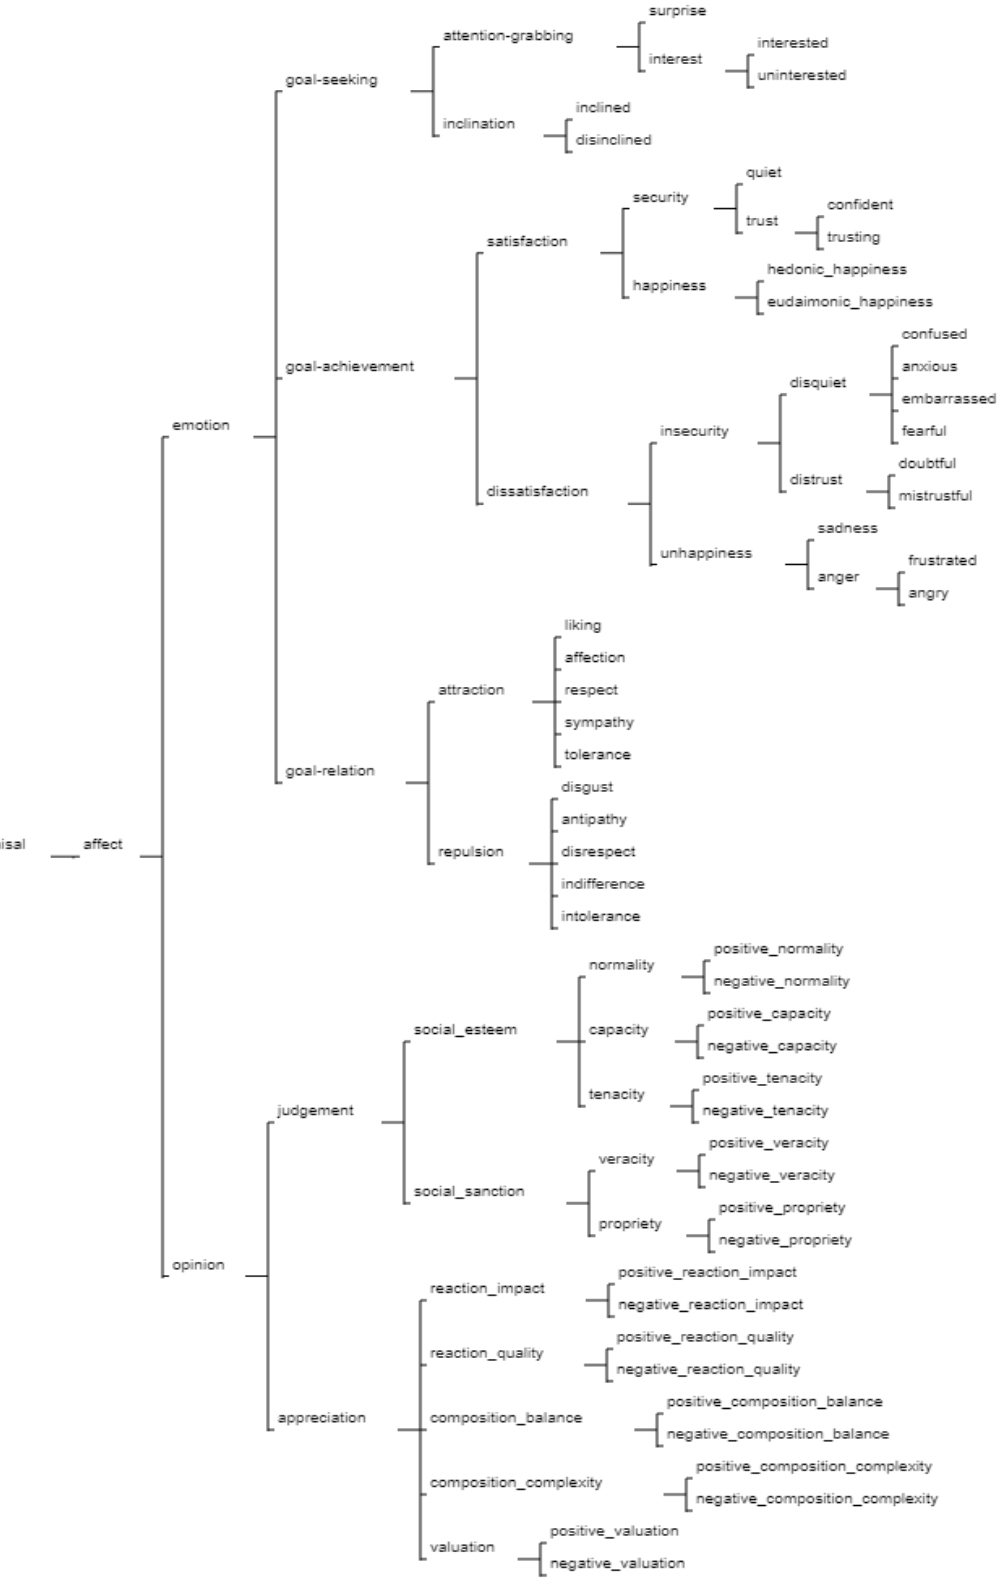
Figure A1. The system of AFFECT and its two sub-systems: EMOTION and OPINION.